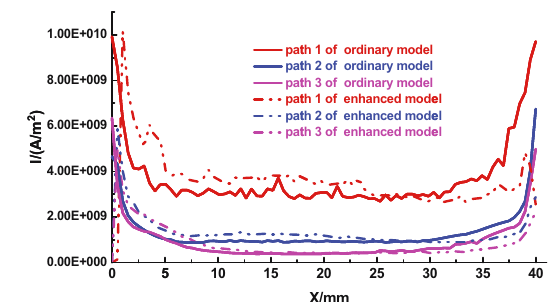
Figure 9: Current distribution on three